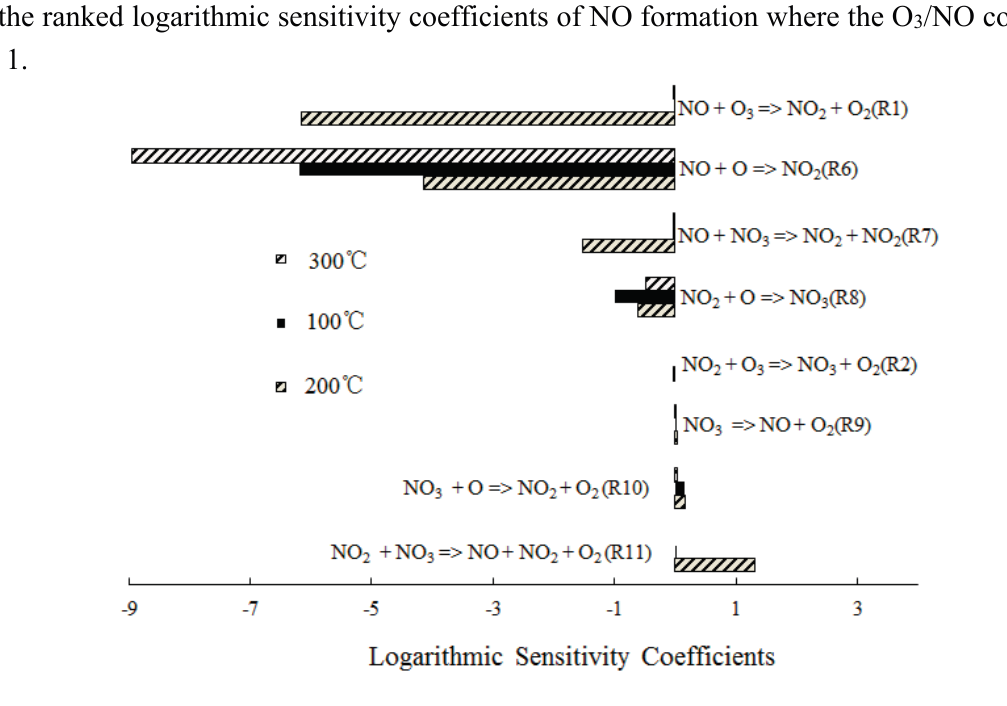
Figure 8. Ranked logarithmic sensitivity coefficients of NO formation where O 3 /NO concentration equals